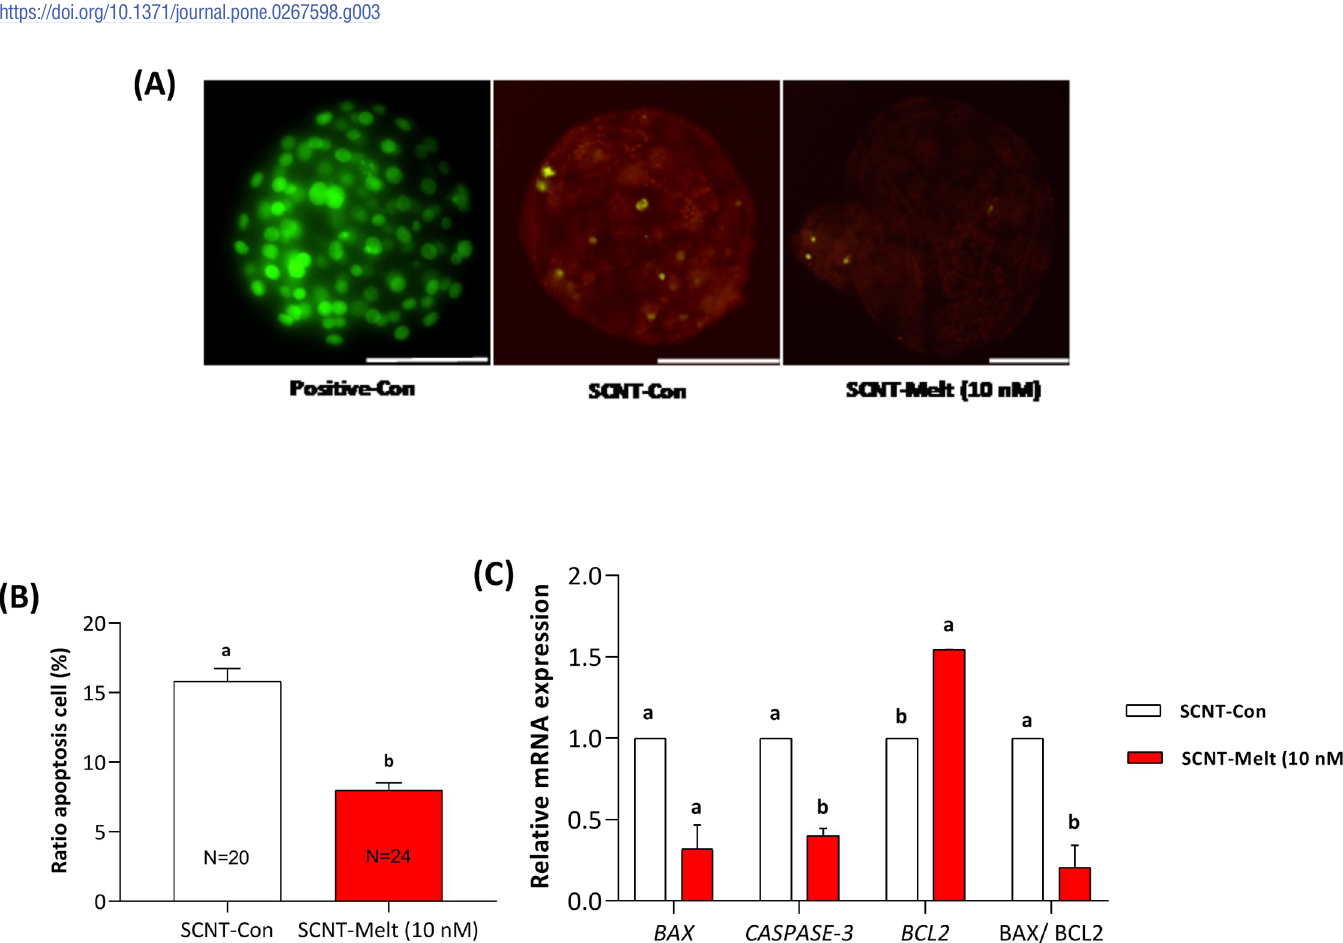
Fig 4. Effect of melatonin on apoptotic index of ovine SCNT embryos and relative mRNA expression of regulating enzymes. A) TUNEL assay of blastocysts (green). Each sample was counterstained with DAPI to visualize DNA (red). Scale bar, 200 μ m B) Total number of apoptotic cells in derived blastocyst from treated groups. C) The relative expression level of apoptosis genes ( CASPASE3 , BAX and BCL2 ) in SCNT-Melt (10 nM) and SCNT-Con groups. The data were shown as mean ± SEM. Values with different letters have a statistically significant difference ( P < 0.05).